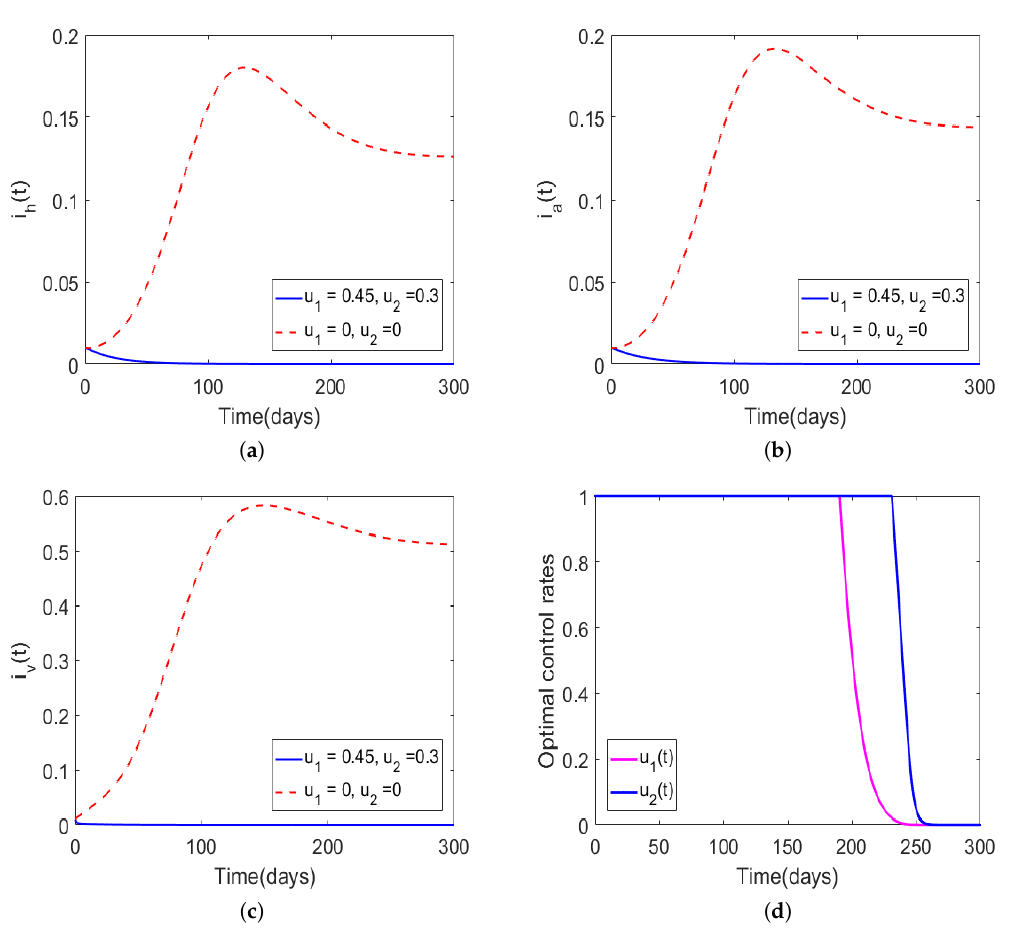
Figure 2. Simulations of model (6) with initial guess for the controls set to u 1 = 0.45, u 2 = 0.3 and the bounds of the controls were q 1 = q 2 = 1. The weight constants were set as w 1 = 10, w 2 = 100, and the model parameter values were adopted from Table 1. The solid curves in ( a – c ) represent the proportion of infectious humans, infectious animals, and infectious tsetse vectors, respectively, in the presence of time-dependent control, and the dotted lines denote the absence of optimal control. The optimal control rates are shown in ( d ).